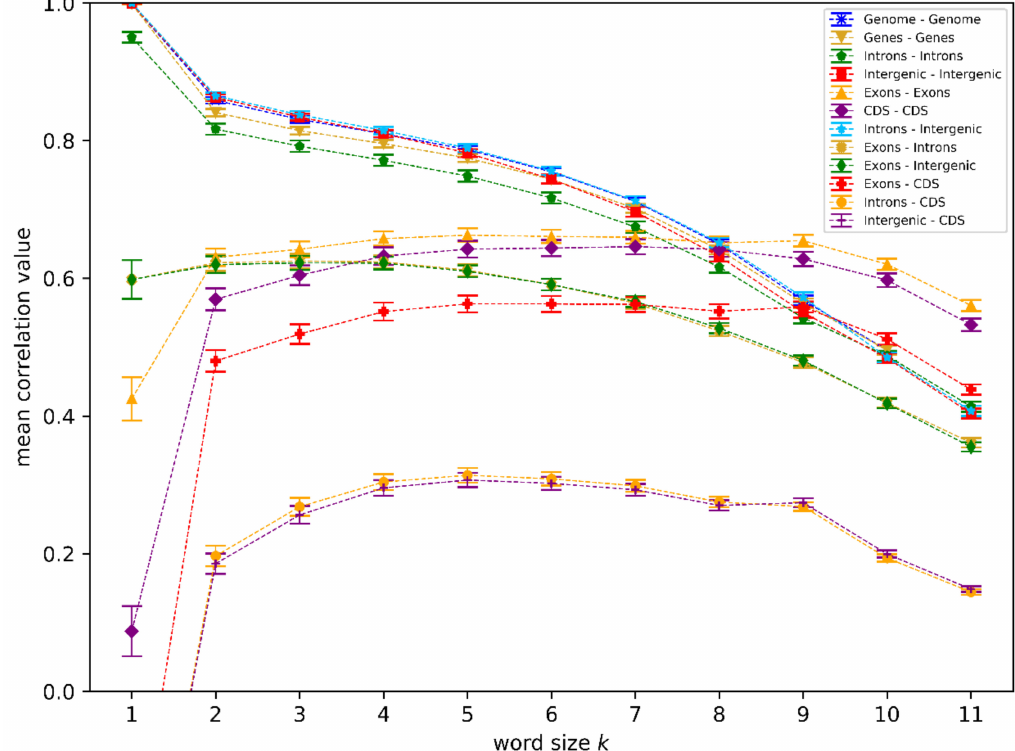
Figure 1. Mean correlation values over all organsims against word length k . Shown are the mean values and uncertainties (see Section 2.1 for details) for k -mer analysis correlation results between pairs of genome regions. We limited the y -axis to values above zero for better readability, and accordingly have not shown the k = 1 correlations for Exon–CDS, Introns–CDS, and